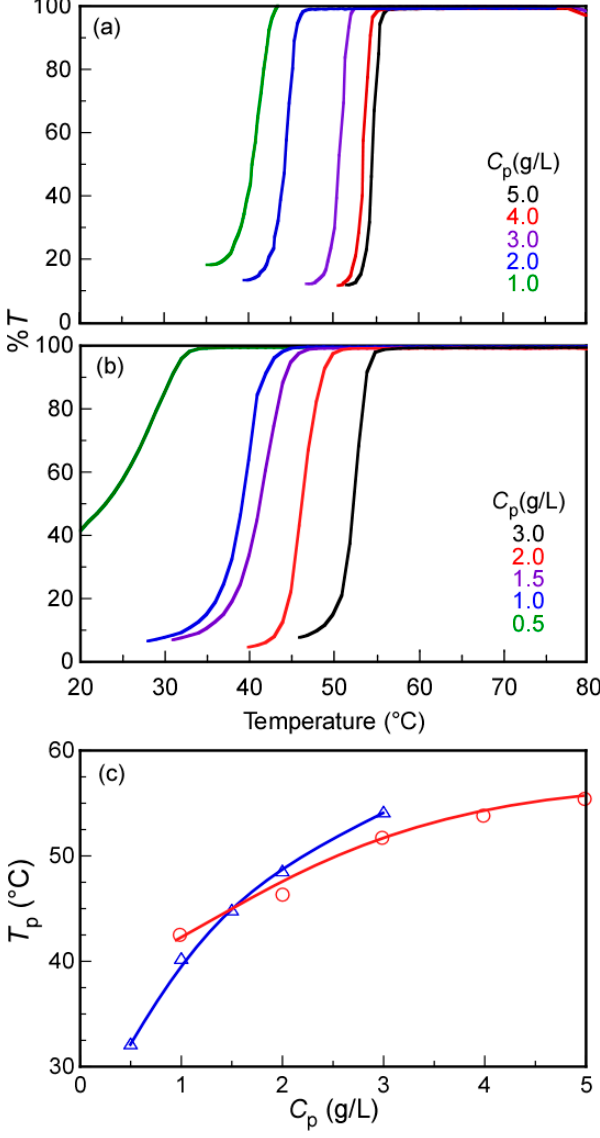
Figure 4. Percent transmittance (% T ) at 700 nm for ( a ) aqueous 0.1 M NaCl P(VBTAC/NaSS) 20 and ( b ) aqueous 1.0 M NaCl P(VBTAC/NaSS) 97 solutions at different C p conditions as a function of temperature upon cooling. ( c ) Polymer concentration ( C p ) dependence of the phase transition temperature ( T p ) for 0.1 M NaCl aqueous P(VBTAC/NaSS) 20 ( 〇 ) and 1.0 M NaCl aqueous P(VBTAC/NaSS) 97 solutions ( △ ).